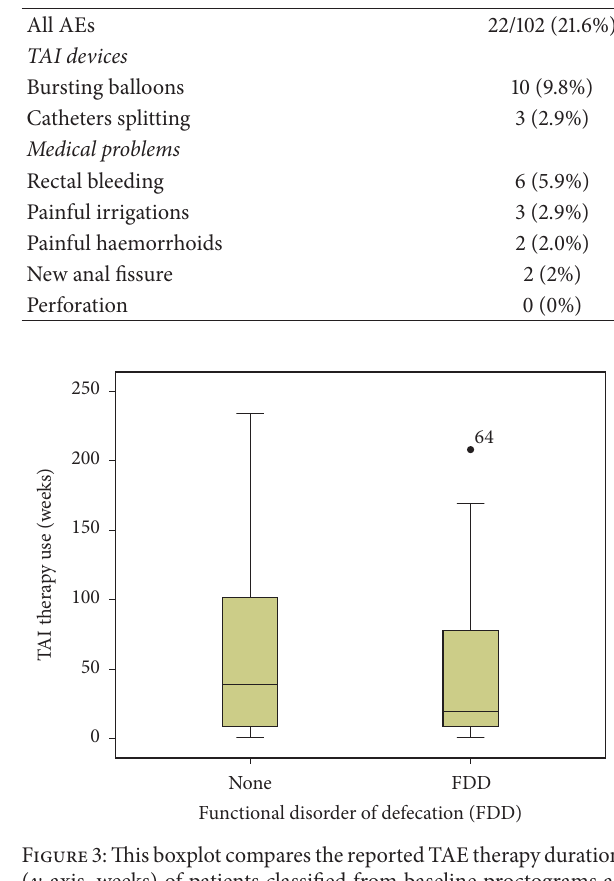
Table 5: Adverse events (AEs).